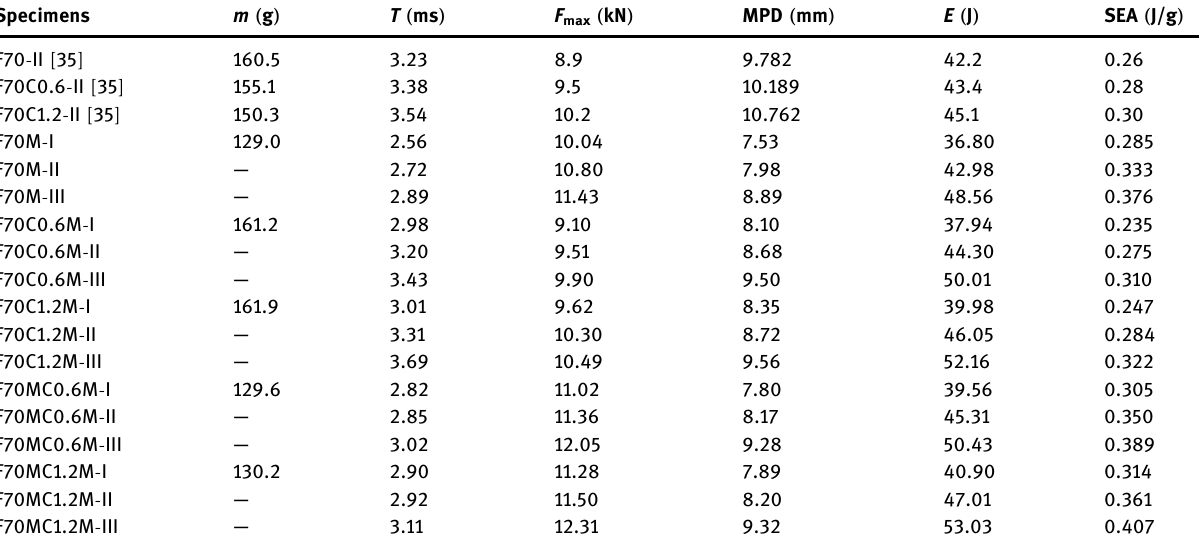
Table 2: Summary of the impact test matrix